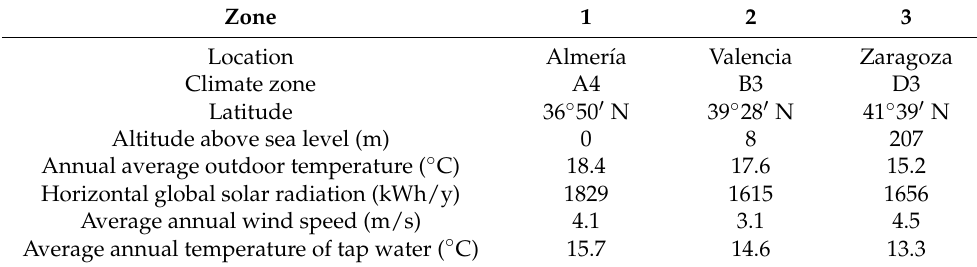
Table 2. Description of the main climate conditions of the selected cities. Source: [28–30]. Zone 1